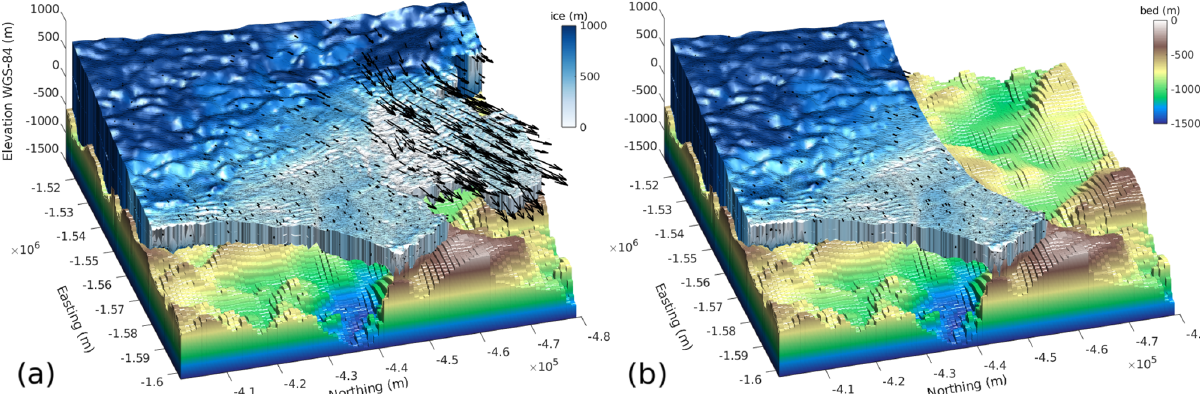
Figure 7. ISSM computational domains used for perturbation experiments with and without the Western Glacier Tongue. Note the deep bathymetric trough stretching from the pinning point area far beneath the Western Glacier Tongue. The bathymetry is our adjusted version of the Jordan et al. (2020) product, and ice thickness is derived from hydrostatic principles on floating parts and from differencing the REMA surface elevation with the bathymetry on grounded parts. Note that the figure is rotated in comparison to all previous figures.